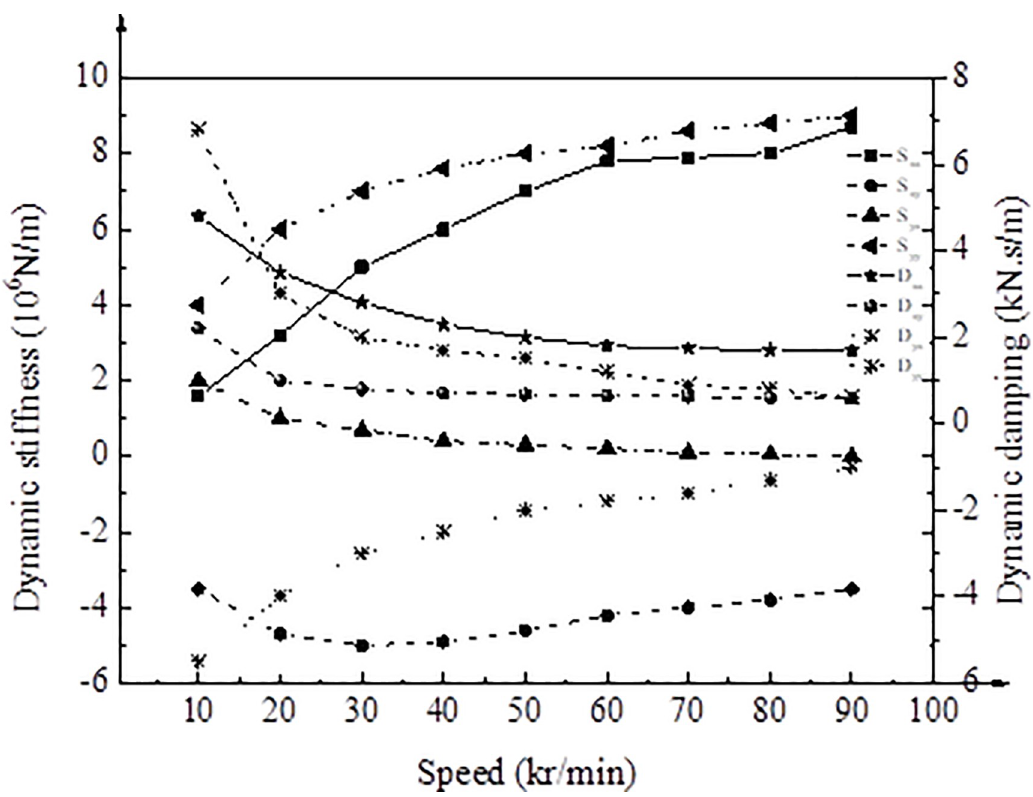
Fig 8. Distribution and changes of dynamic stiffness and dynamic damping for the gas bearing at various rotating speeds. Note: in the legend, S represents the dynamic stiffness, and D represents the dynamic damping.